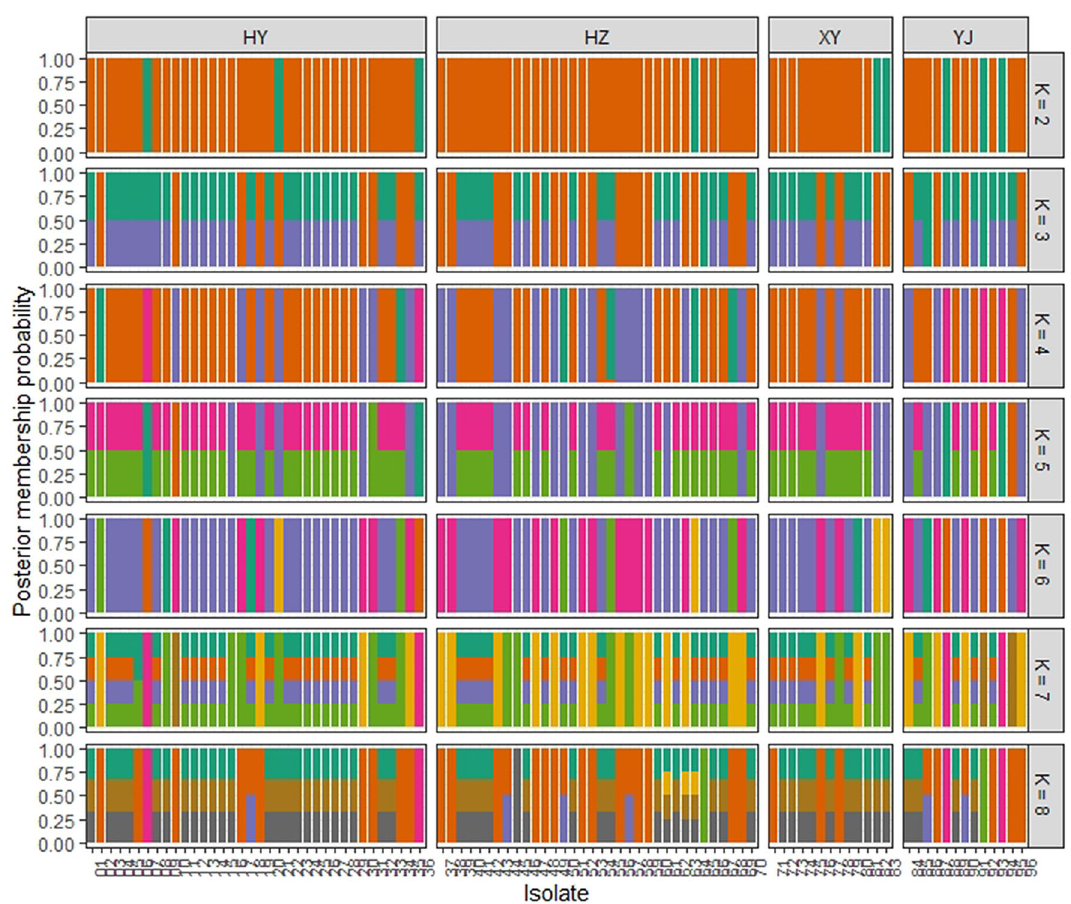
Figure 4. Discriminant analysis of principal components (DAPC) of the 96 P. polysora isolates. Posterior membership probabilities of each isolate based on the discriminant functions of DAPC. The group K was set from 2 to 8. Each isolate is represented by a vertical